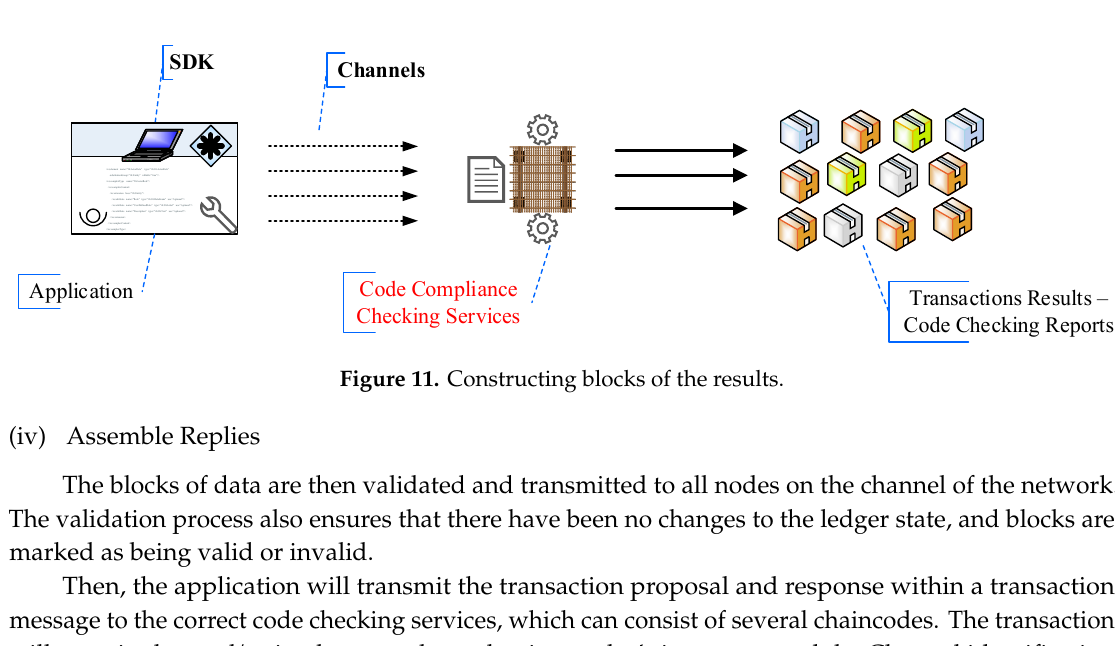
Figure 13. Updating the Hyperledger.